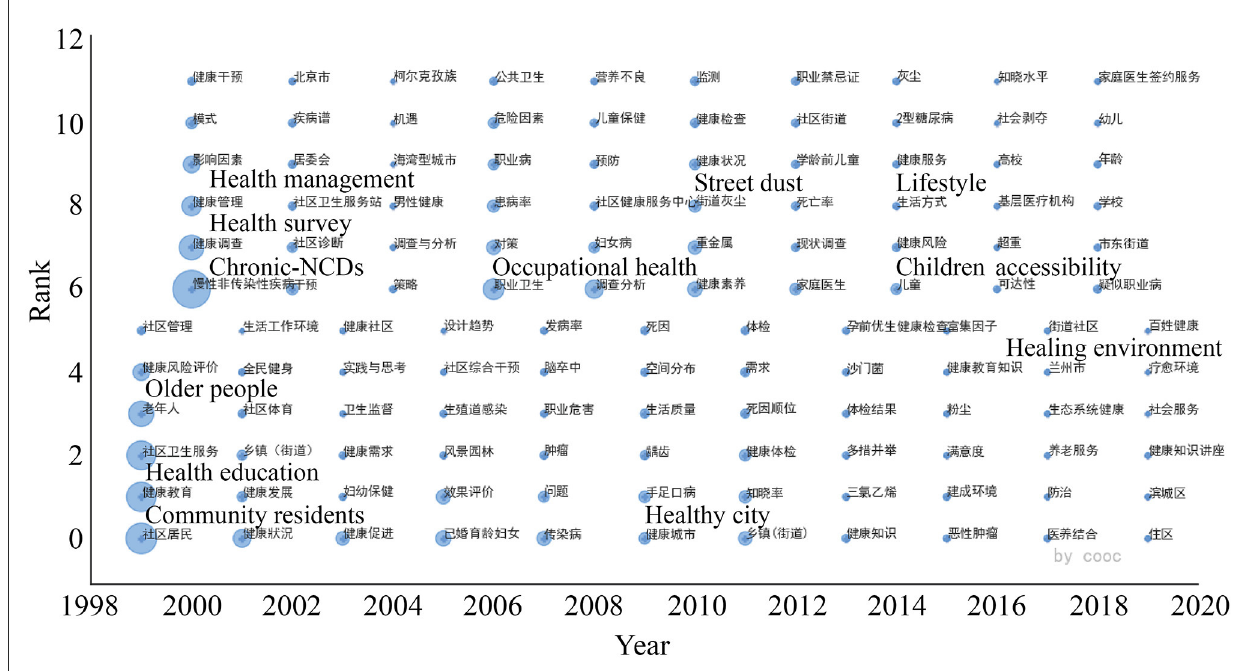
FIGURE4 Cumulative time zone diagram of the evolution of research themes 1999–2019.